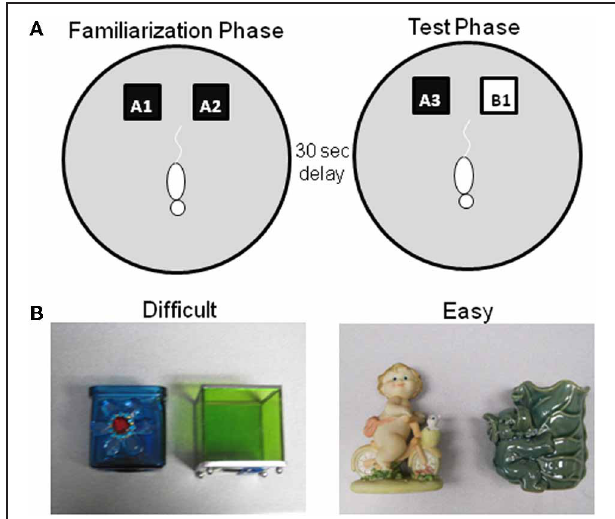
FIGURE 3 | Schematic of spontaneous object recognition task using objects with similar features. (A) The testing arena is a circle ∼ 201cm in circumference with a wooden floor and 40.6cm high walls. The black squares indicate the location in which that the objects are fixed in place during the familiarization phase (left arena). The schematic white rat is shown in the initial orientation of the rat when it is first placed in the arena. In the object familiarization phase (right arena), a rat is placed into the arena to explore duplicate copies of an object (A1 and A2). The rat is then moved from the arena and placed into a covered pot adjacent to the arena for a 30s delay. Following the delay, during the test phase (bottom arena), the animal is returned to the arena to explore a triplicate copy of the objects presented during the familiarization phase (A3) and a novel object (B1). (B) Example objects used for the two trials of this task, both of which have a 30s delay between the familiarization and test phases. In one condition the objects are similar to each other (Left panel–Difficult), while in the other condition the objects are distinct and share no features (Right panel–Easy) (after Burke et al.,